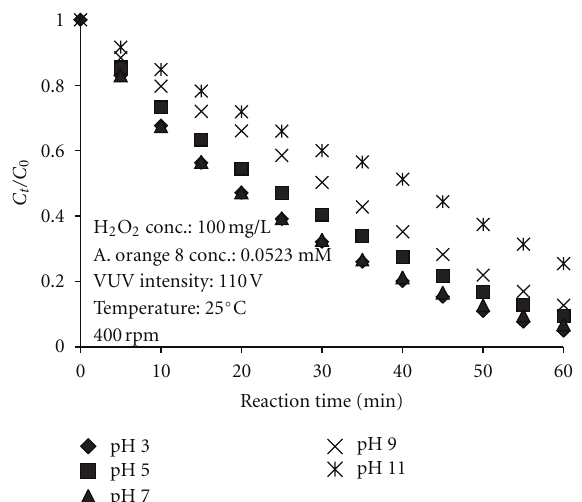
Figure 3: The degradation of acid Orange 8 at di ff erent pH in aqueous solutions by VUV/H 2 O 2